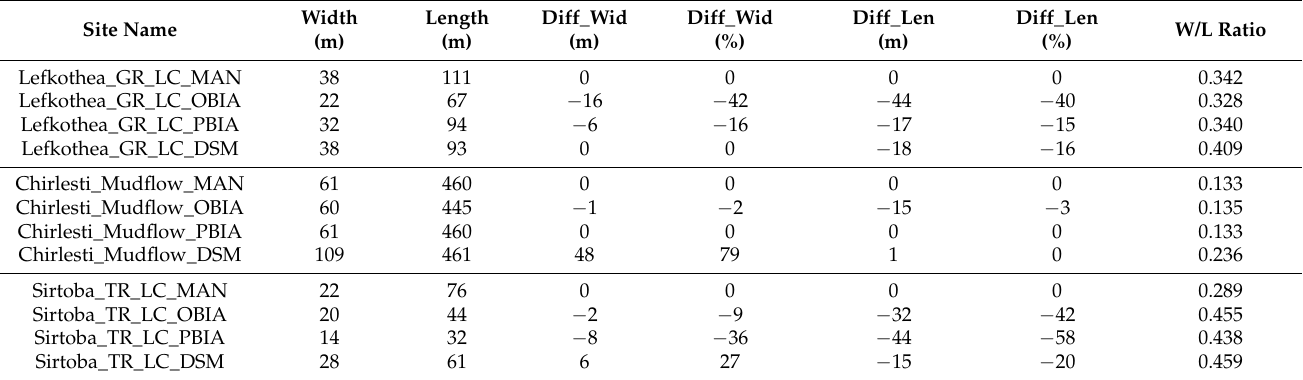
Table 6. Statistics were produced for each landslide’s width, length, and width/length ratio for the three case studies. The differences were between control (manual) and the other classifications. The numbers were rounded to the nearest